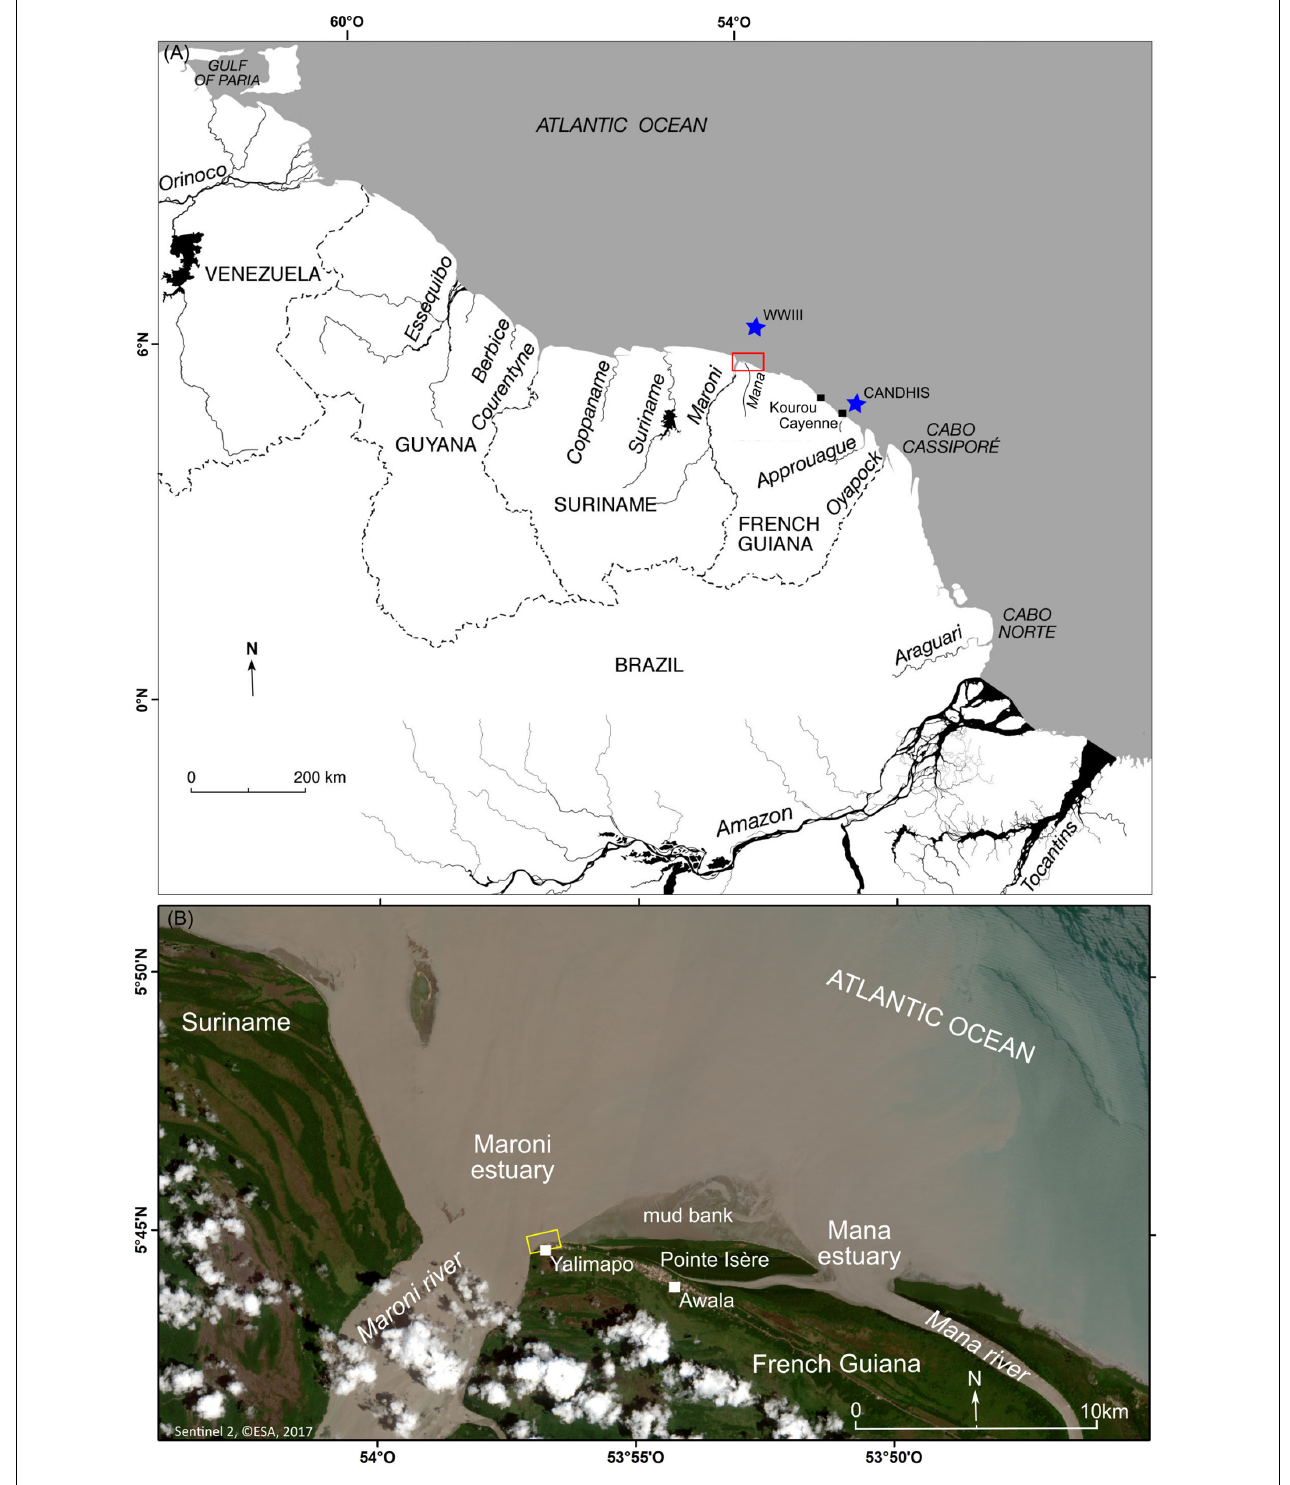
FIGURE 1 | (A) Map of the Guianas coast between the deltas of the Amazon and Orinoco Rivers, and study area (red box). Also shown are several smaller rivers, among which the Maroni, and the Mana in western French Guiana. (B) SENTINEL 2 satellite image showing a close-up view of the mouth of the Maroni River and the neighboring Mana River, the former mouth of which (located at Awala) has been sealed by shore-attached mud following erosion of much of Pointe Isère, a mud cape extant since at least the mid-19th century. Yellow box shows aerial and ground photos on Figure 5 .